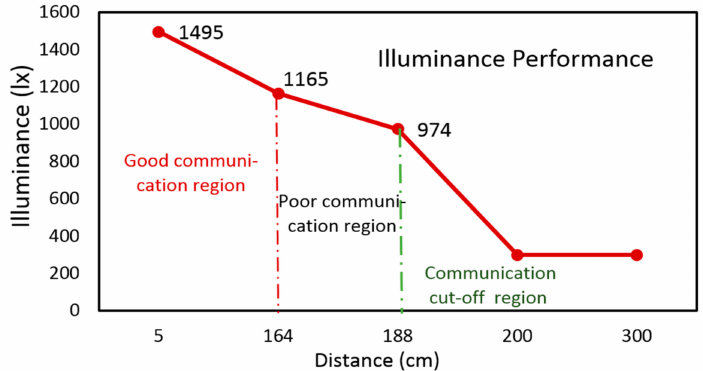
Figure 14. Test on illuminance performance of leader robot.